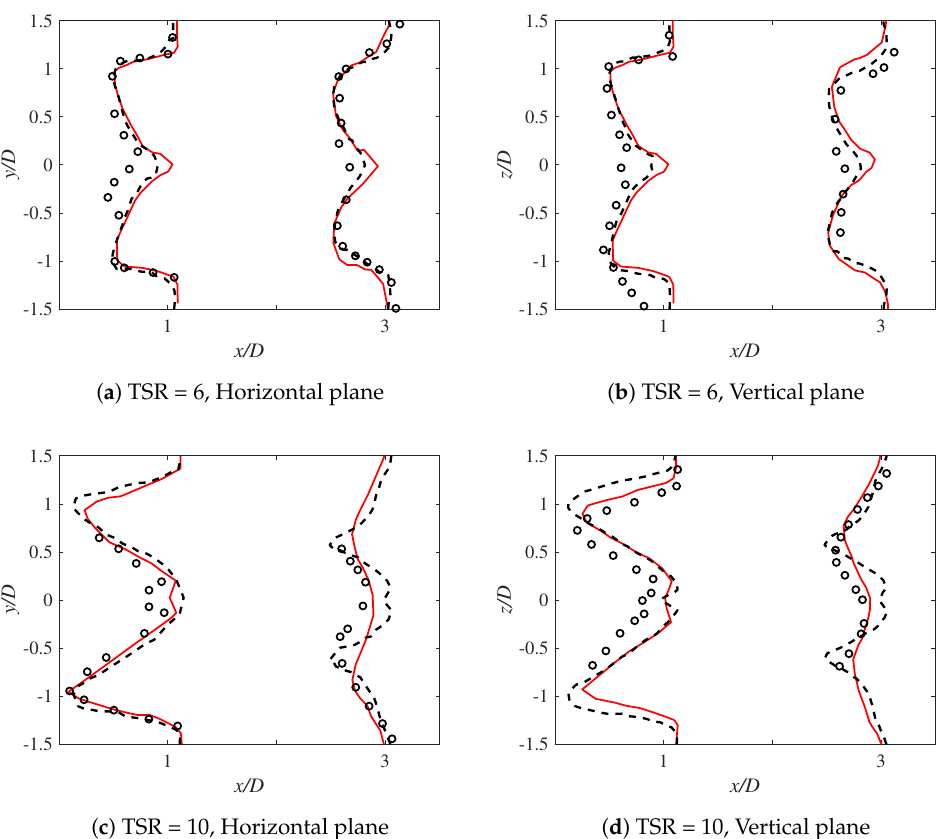
Figure 11. HAWT-S826: Comparison of the velocity deficit using Case-IV (360 ◦ rotor), at successive locations of x / D of 1 and x / D of 3 in the wake region and TSR values of 6 ( a , b ) and 10 ( c , d ). Velocity profiles were predicted by MRF (solid lines) and SMI (dotted lines) with the results of the experiment (circles) taken from [37]. Successive profiles were offset for better